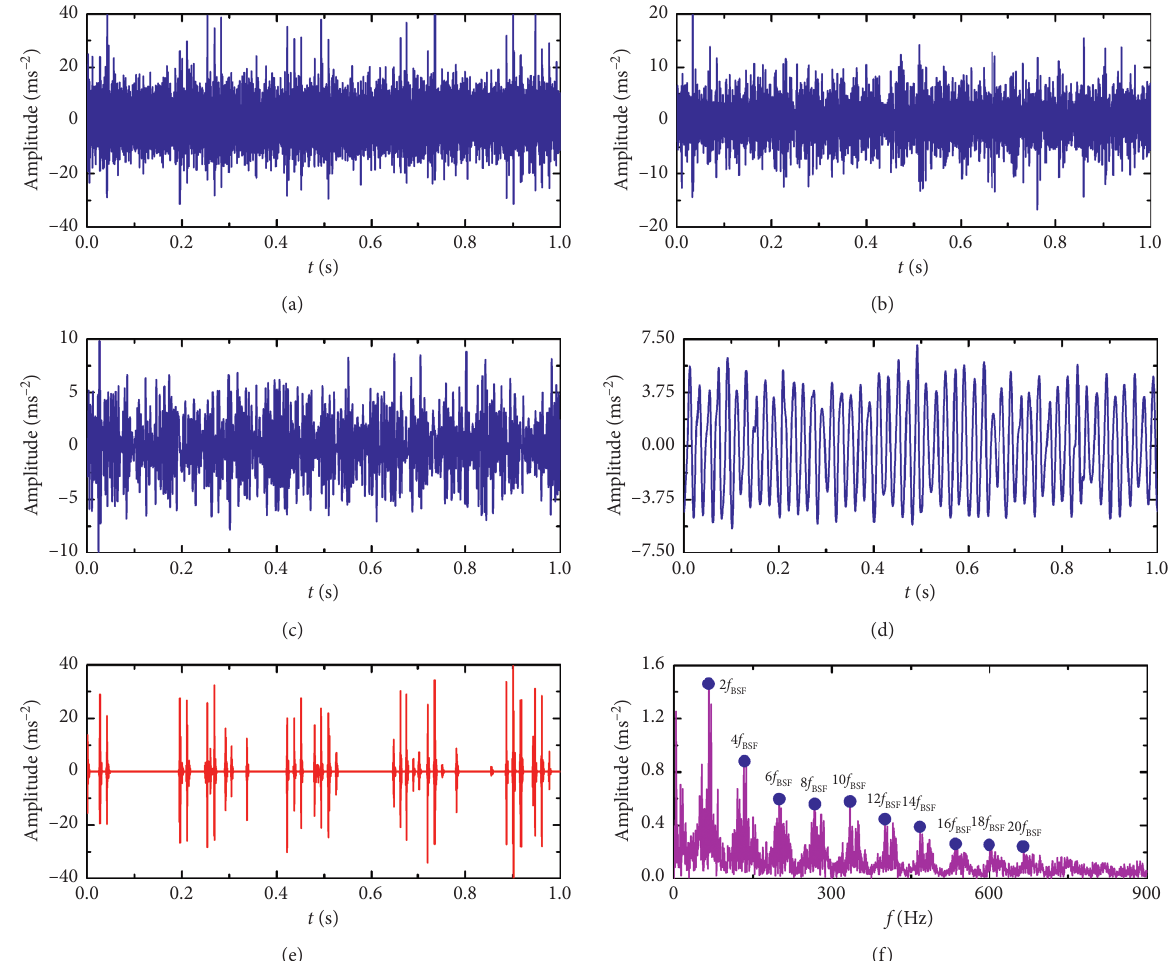
Figure 19: Results obtained by the proposed ALIF-SBAKW: (a–d) IMF1-IMF4, (e) extracted impulses, and (f) Hilbert envelope spectrum of signal in